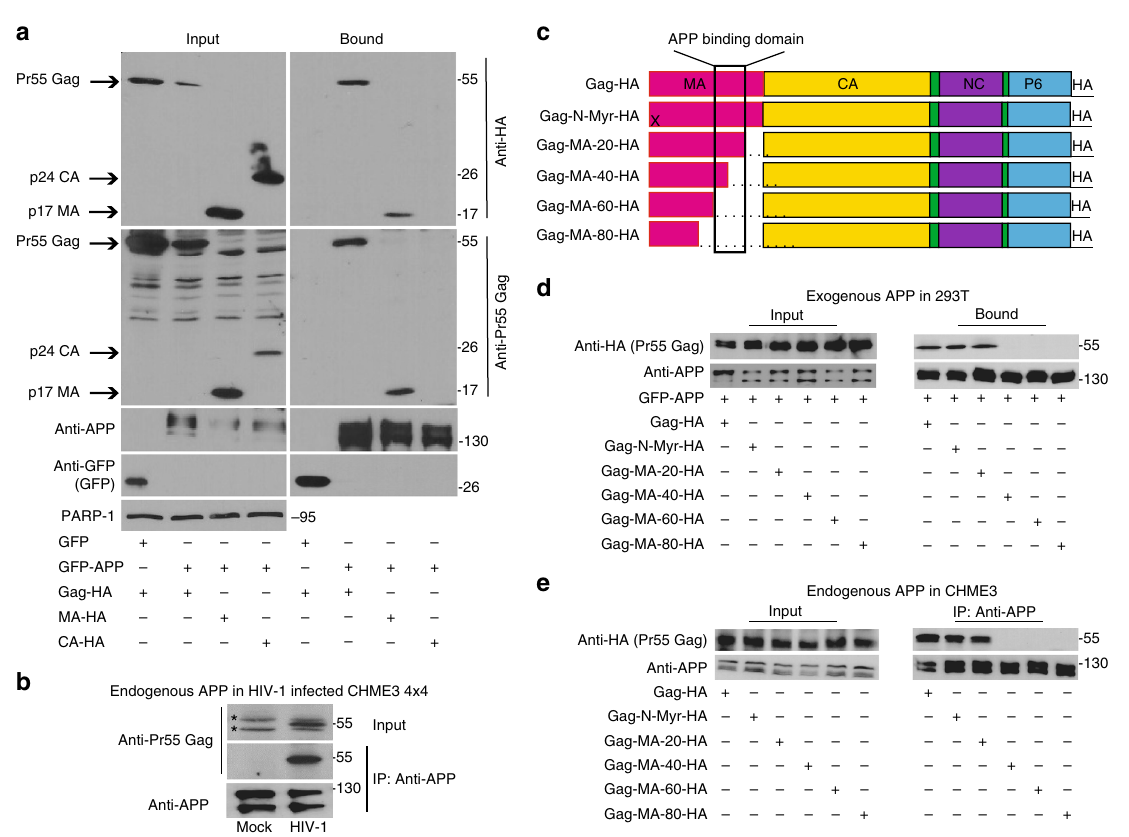
Fig. 2 APP binds the MA region of HIV-1 Gag. a GFP-tagged human APP 770 (GFP-APP), but not GFP control, binds HIV-1 Gag (Gag-HA) or Matrix (MA- HA), but not Capsid (CA-HA) in GBP-binding assays. b Endogenous APP interacts with Pr55 Gag in WT HIV-1-infected CHME3 4 × 4 cells in anti-APP co- IP. *indicates unspeci fi c bands detected in cell lysates. c Schematic of the HIV-1 Gag polyprotein used in binding assays, including the c-terminal HA tag. X indicates a point mutation in the N-terminal myristoylation site (Gag-N-Myr-HA). Sequential 20 aa deletions are indicated. d Gag mutants lacking aa 72-111 of MA (Gag-MA-40-HA, Gag-MA-60-HA, or Gag-MA-80-HA) fail to bind GFP-APP in co-transfected 293T cells in GBP-binding assay. e Gag mutants lacking aa 72-111 of MA (Gag-MA-40-HA, Gag-MA-60-HA, or Gag-MA-80-HA) fail to bind endogenous APP in CHME3 cells in anti-APP co-IP. Molecular weight markers (in kDa) are shown to the right of